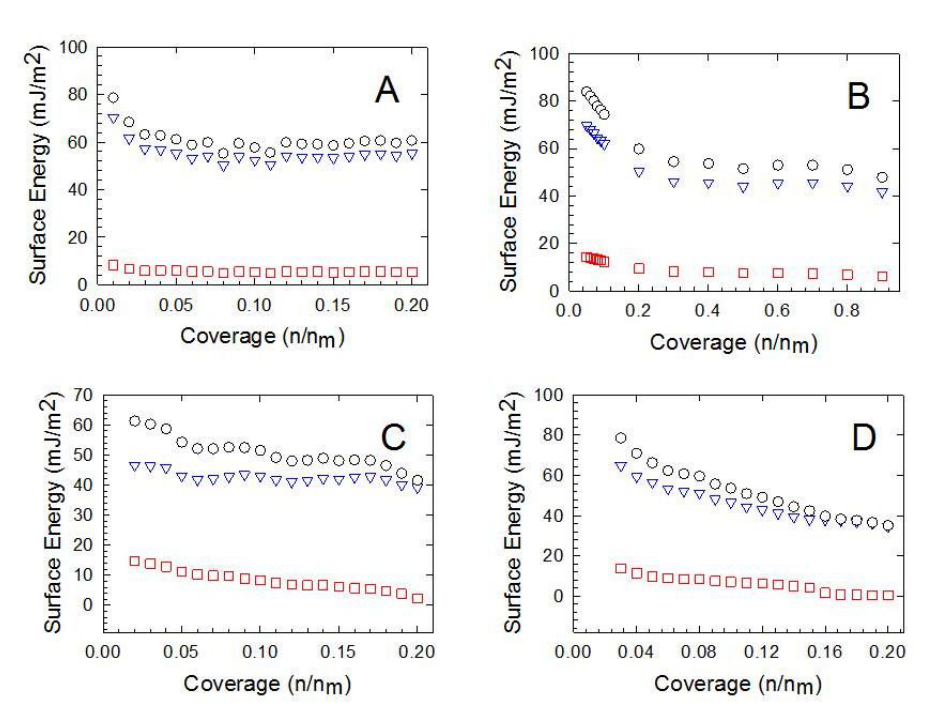
Figure 1: Surface energy profiles of studied fillers: A – calcium carbonate hollow spheres (sample 1), B – mica (sample 2), C – wollastonite (sample 3), D – perlite (sample 4). Square – polar part of the surface energy, triangle – dispersive part and circle – total surface